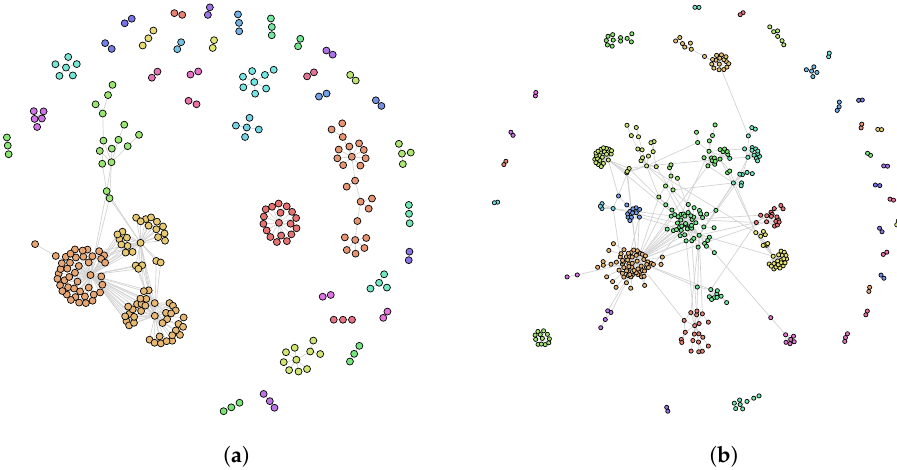
Figure 6. Community structure identified by H YBRID -IA on ( a ) Cattle PPI and ( b ) E. coli TRN